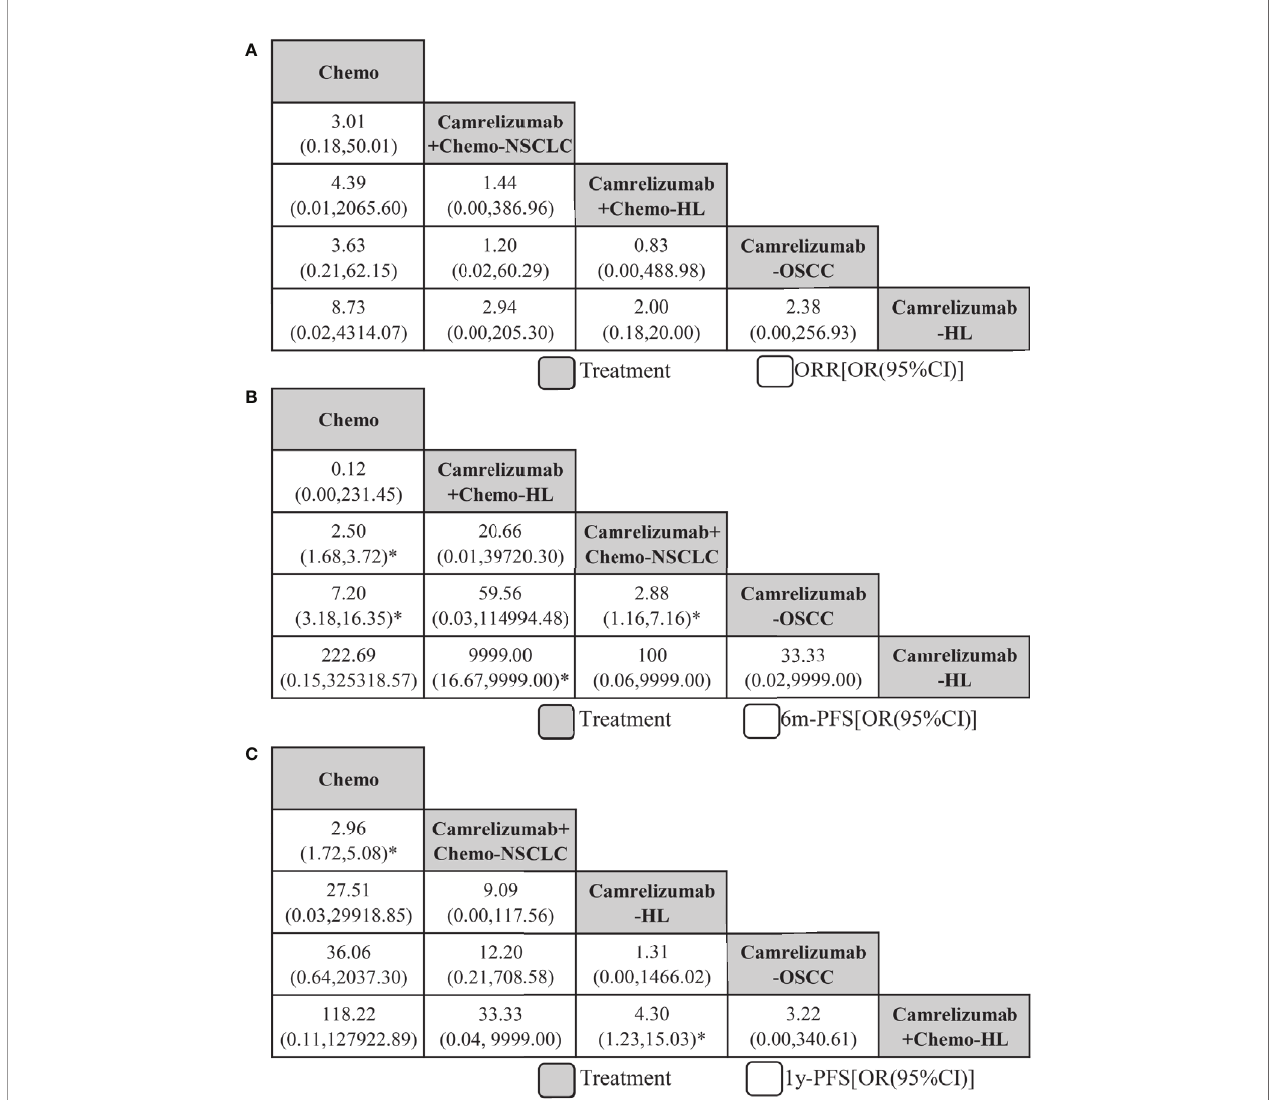
FIGURE 3 | Network meta-analysis of ef fi cacy outcomes including objective response rate (A) , 6-month progression-free survival (B) , and 1-year progression-free survival (C) . From right to left, treatments are ranked by mean rank and SUCRA score. Comparisons between treatments should be read from right to left, and the estimate is in the cell in common between the column-de fi ning treatment and the row-de fi ning treatment, and an OR less than 1 favors the row-de fi ning treatment. To obtain OR for comparisons in the opposing direction, reciprocals should be taken. Chemo, chemotherapy; HL, Hodgkin lymphoma; OSCC, esophageal squamous cell carcinoma; NSCLC, non-squamous non-small-cell lung cancer. *Signi fi cant